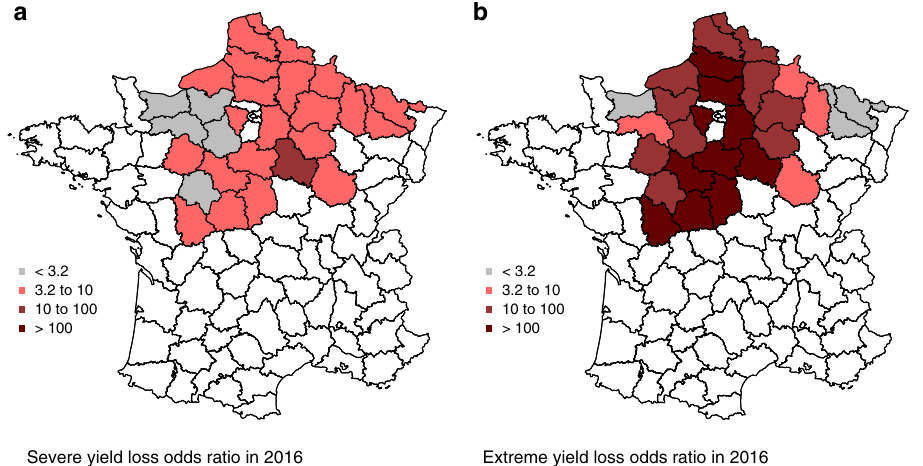
Fig. 5 Odds of yield loss in 2016. Odds ratios of severe ( a ) and extreme ( b ) yield loss in the study area from the best models trained on yield data excluding 2016. Data are shown in Supplementary Table 3. Models include temperature and precipitation conditions in the late autumn and spring. We rely on the odds ratio classi fi cation by 68 with values from 1 to 3.2 not worth more than a bare mention, between 3.2 and 10 suggesting substantial evidence, from 10 to 100 strong and above 100 decisive. The maps were generated with R based on the yield data used in the